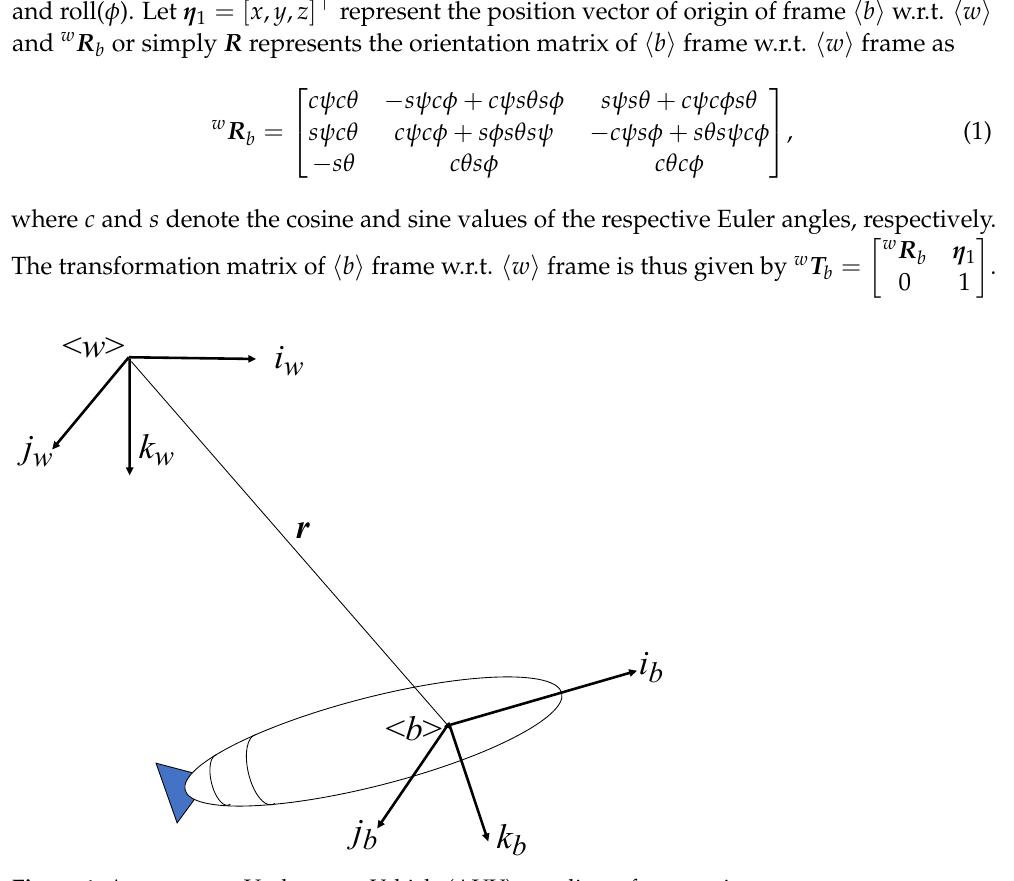
Figure 1. Autonomous Underwater Vehicle (AUV) coordinate frame